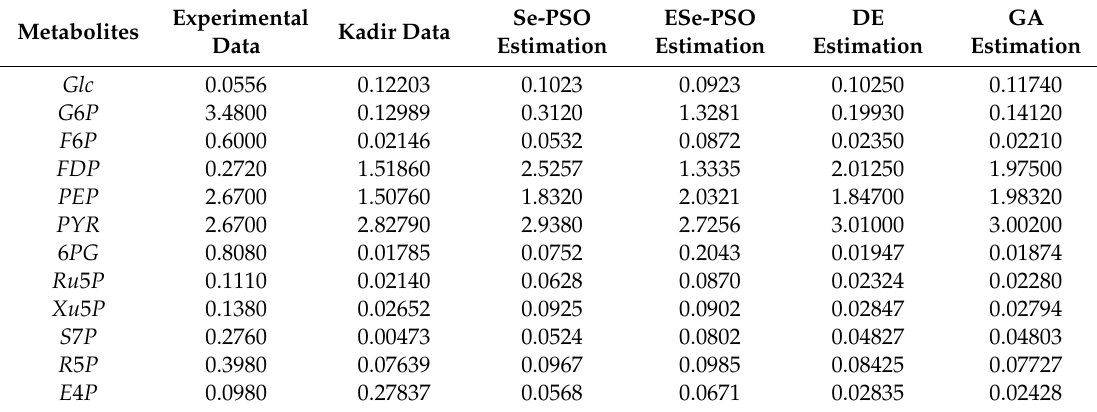
Table3. ComparisonofEnhancedSegmentParticleSwarmOptimizationalgorithm(ESe-PSO)algorithm estimations with Segment Particle Swarm Optimization algorithm (Se-PSO), Di ff erential Evolution (DE) and Genetic Algorithm (GA)